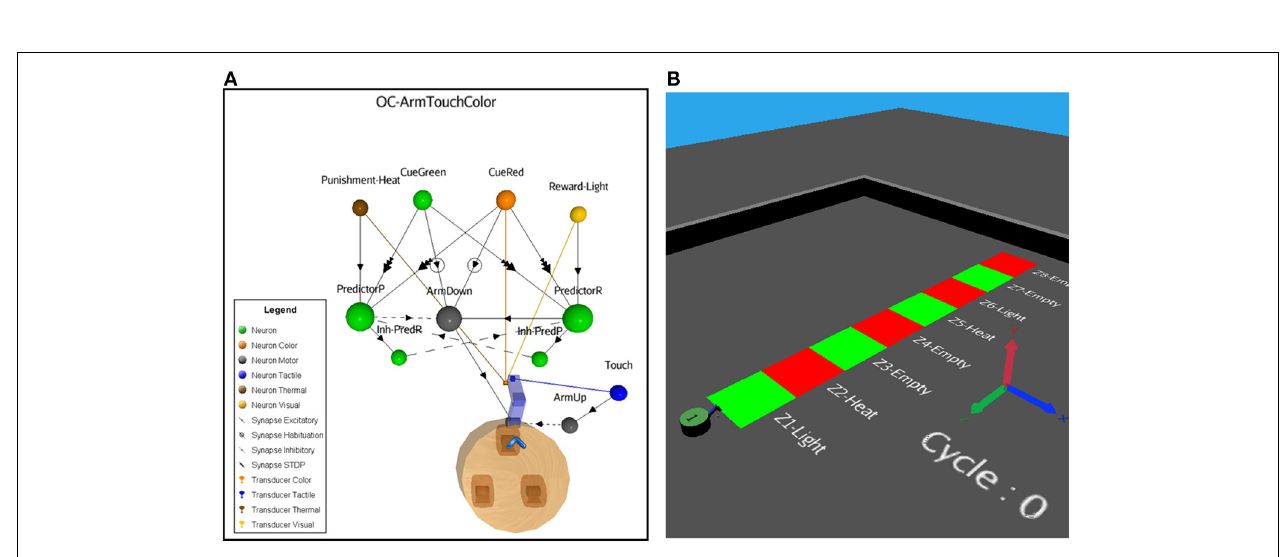
FIGURE 8 | (A) ASNN corresponding to the arm-down behavior when the robot passes over color bars on the floor. The structure of a minimal components requirement is duplicated and shares a common Action neuron.